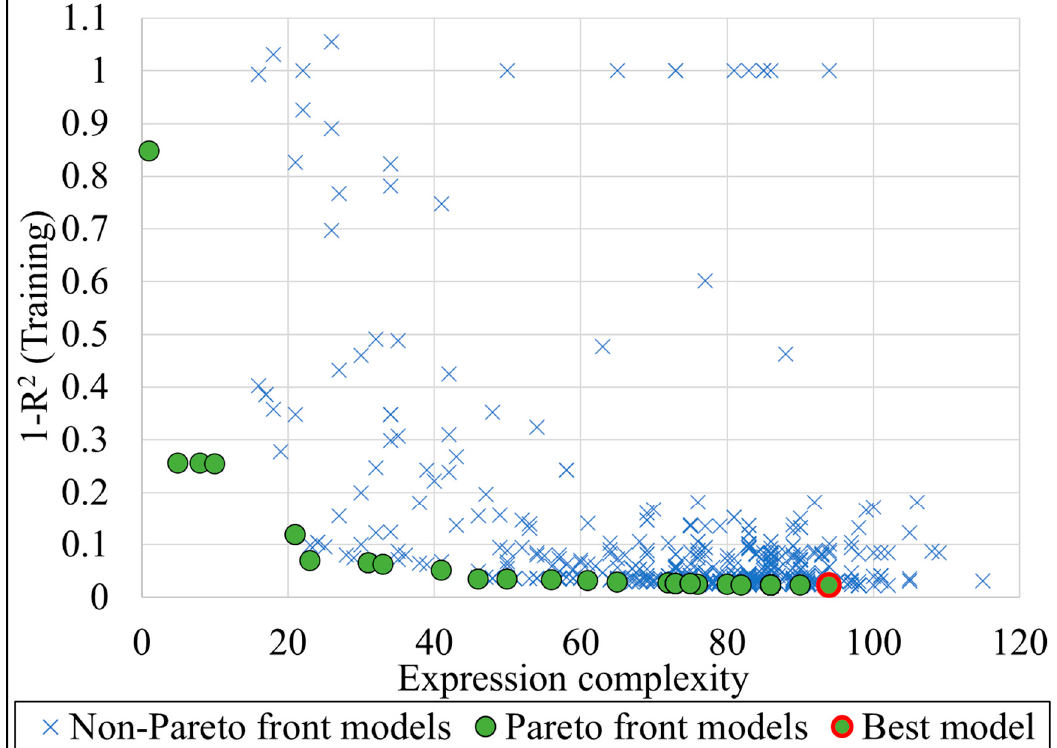
Figure 9. Example of the fluctuations in the training error while searching for the best model.